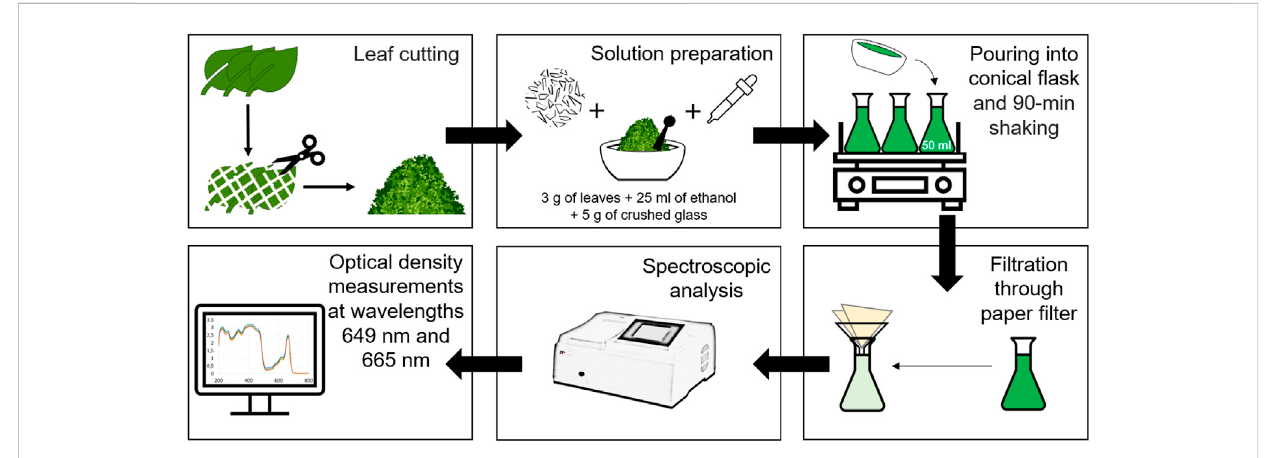
FIGURE 3 Protocol of spectrophotometric analysis applied for reference CC